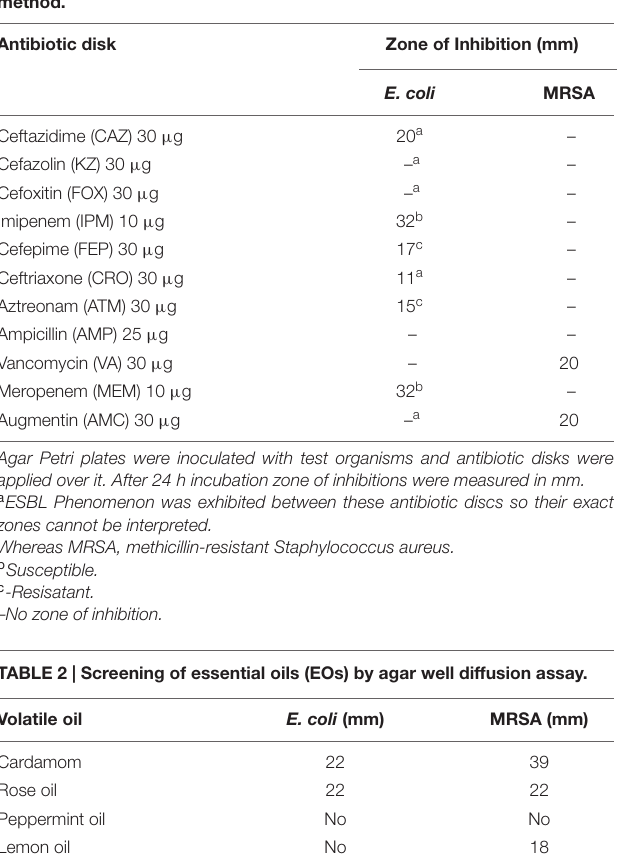
TABLE 1 | Resistance spectra of selected microbes by disk diffusion method.